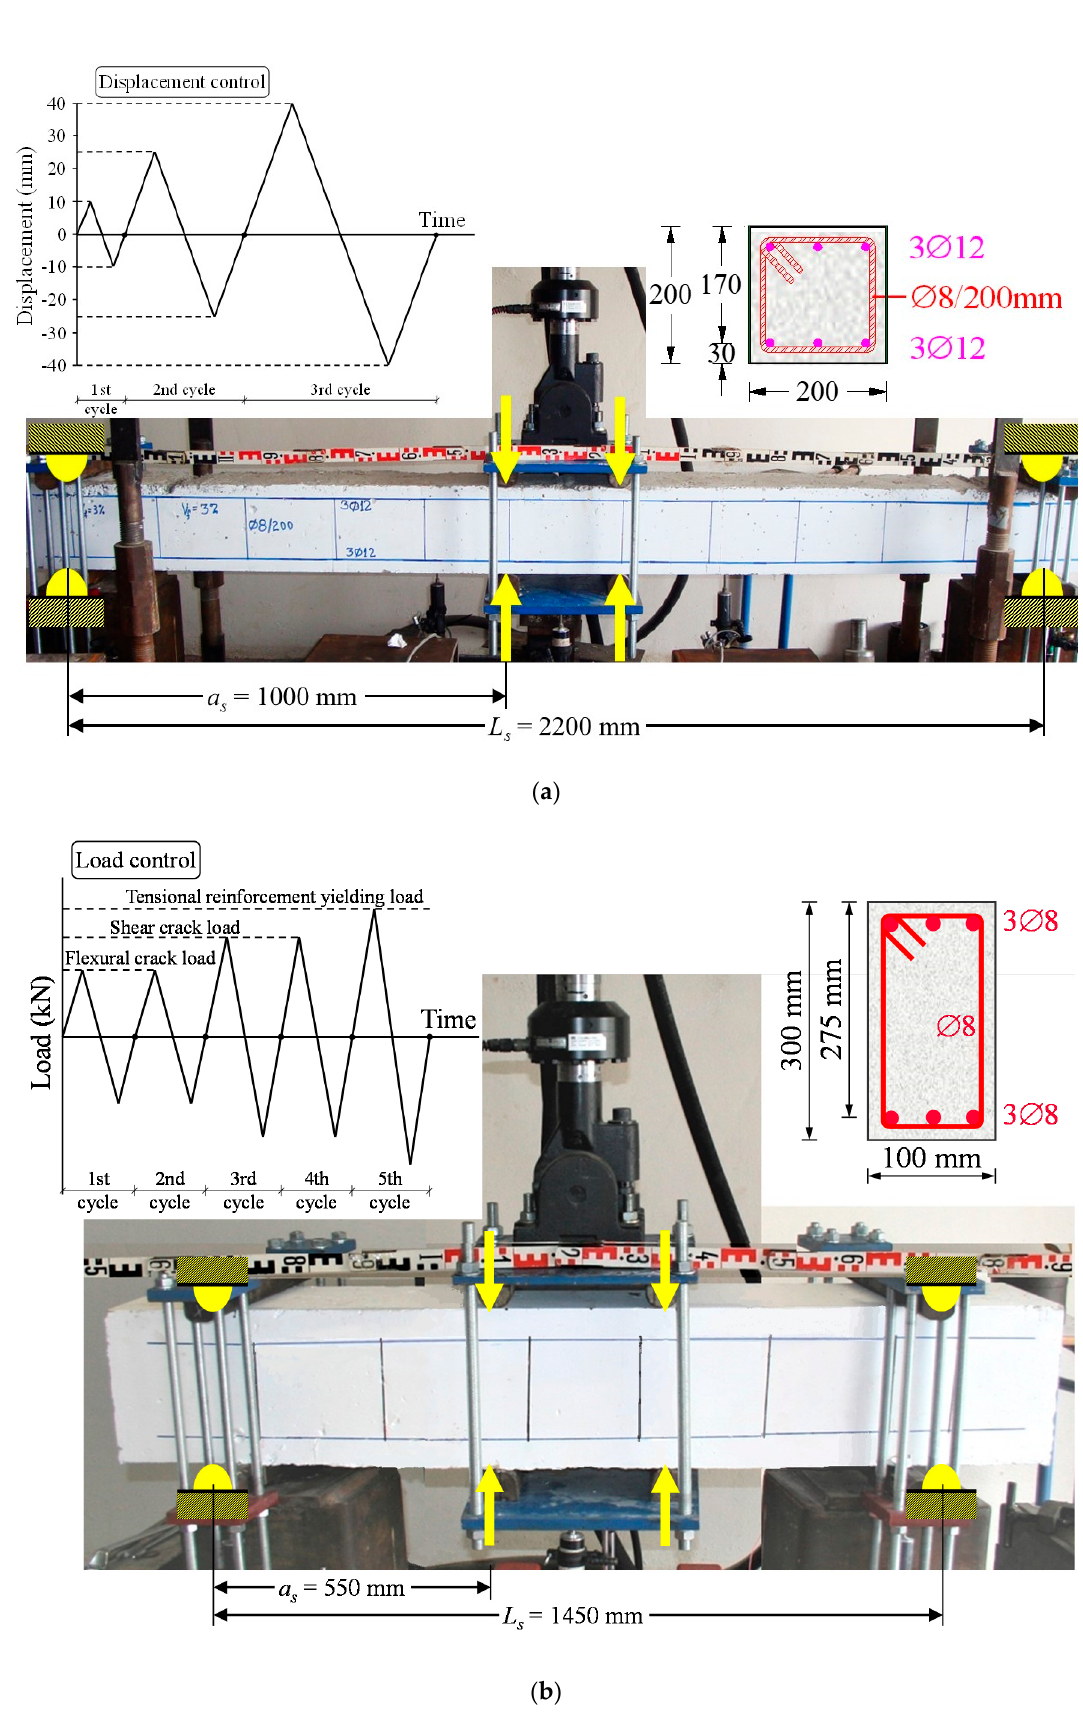
Figure 1. Geometry, reinforcement and cyclic reversal loading sequence of the tested specimens (dimensions in mm): ( a ) slender (flexural) beams; ( b ) deep (shear-critical) beams.